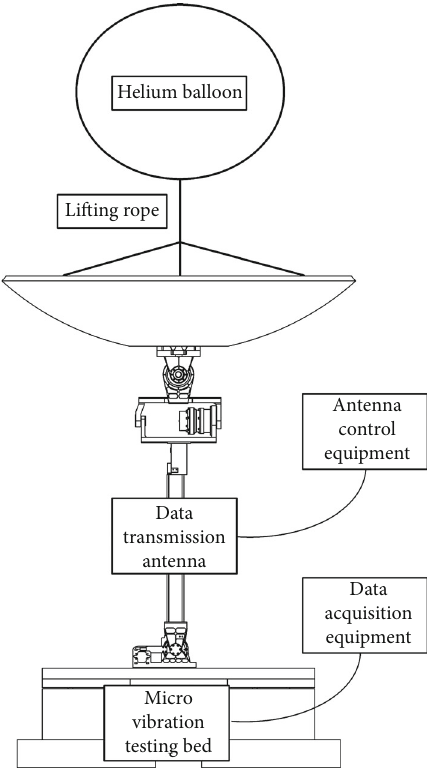
Figure 6: Microvibration experiment of the data transmission